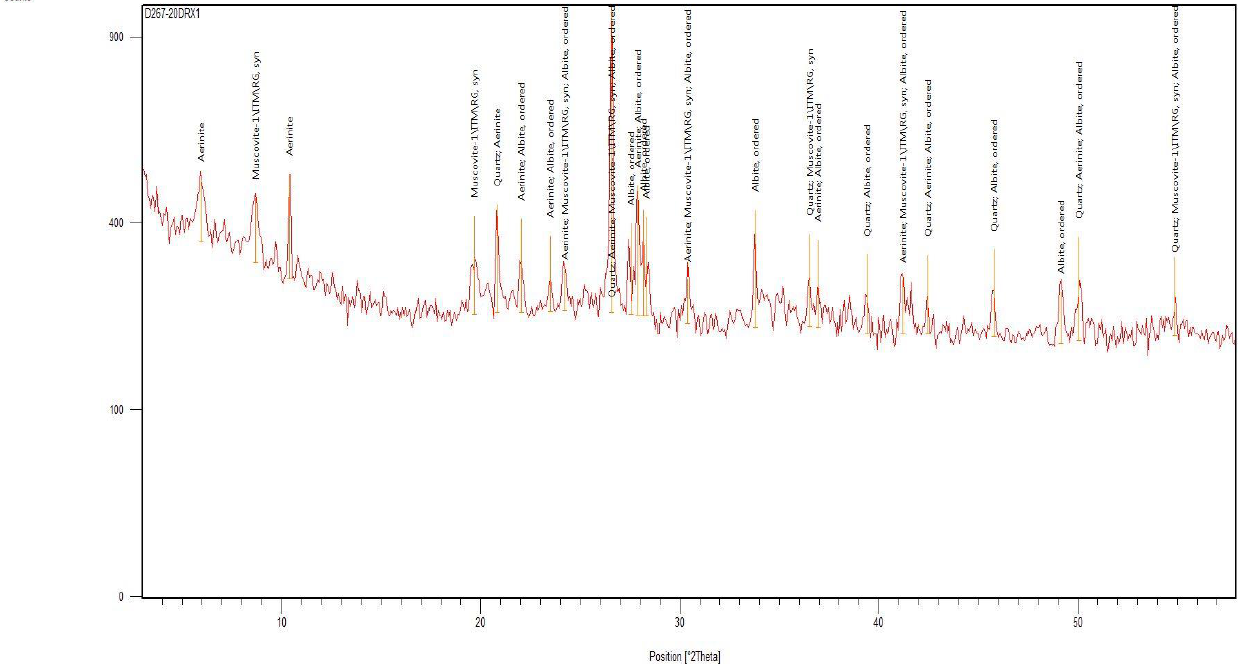
Diffractogram of X-rays on powder and on oriented blades of the T1 sample.